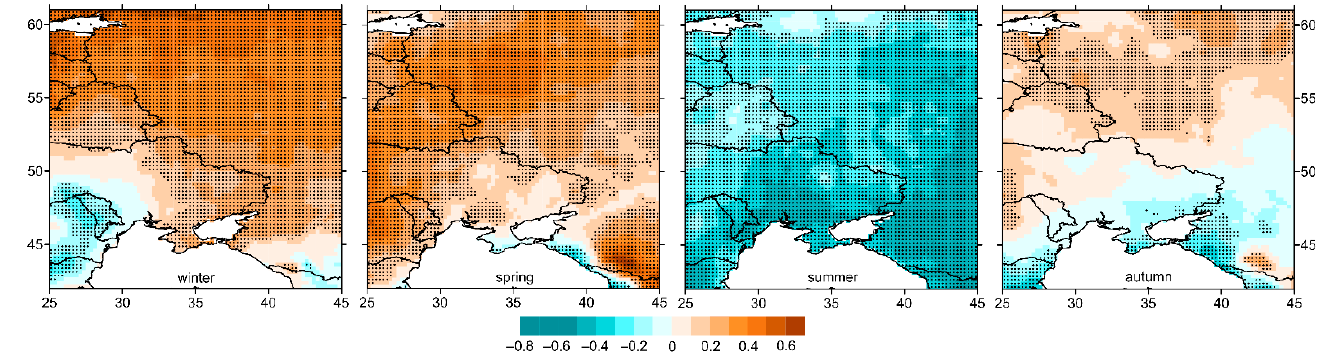
Figure 3. The spatial distribution of Pearson’s correlation coefficients for the monthly air temperature and precipitation in 1950–2018. Statistically significant correlation coefficients ( p < 0.05) are shown as black dots.